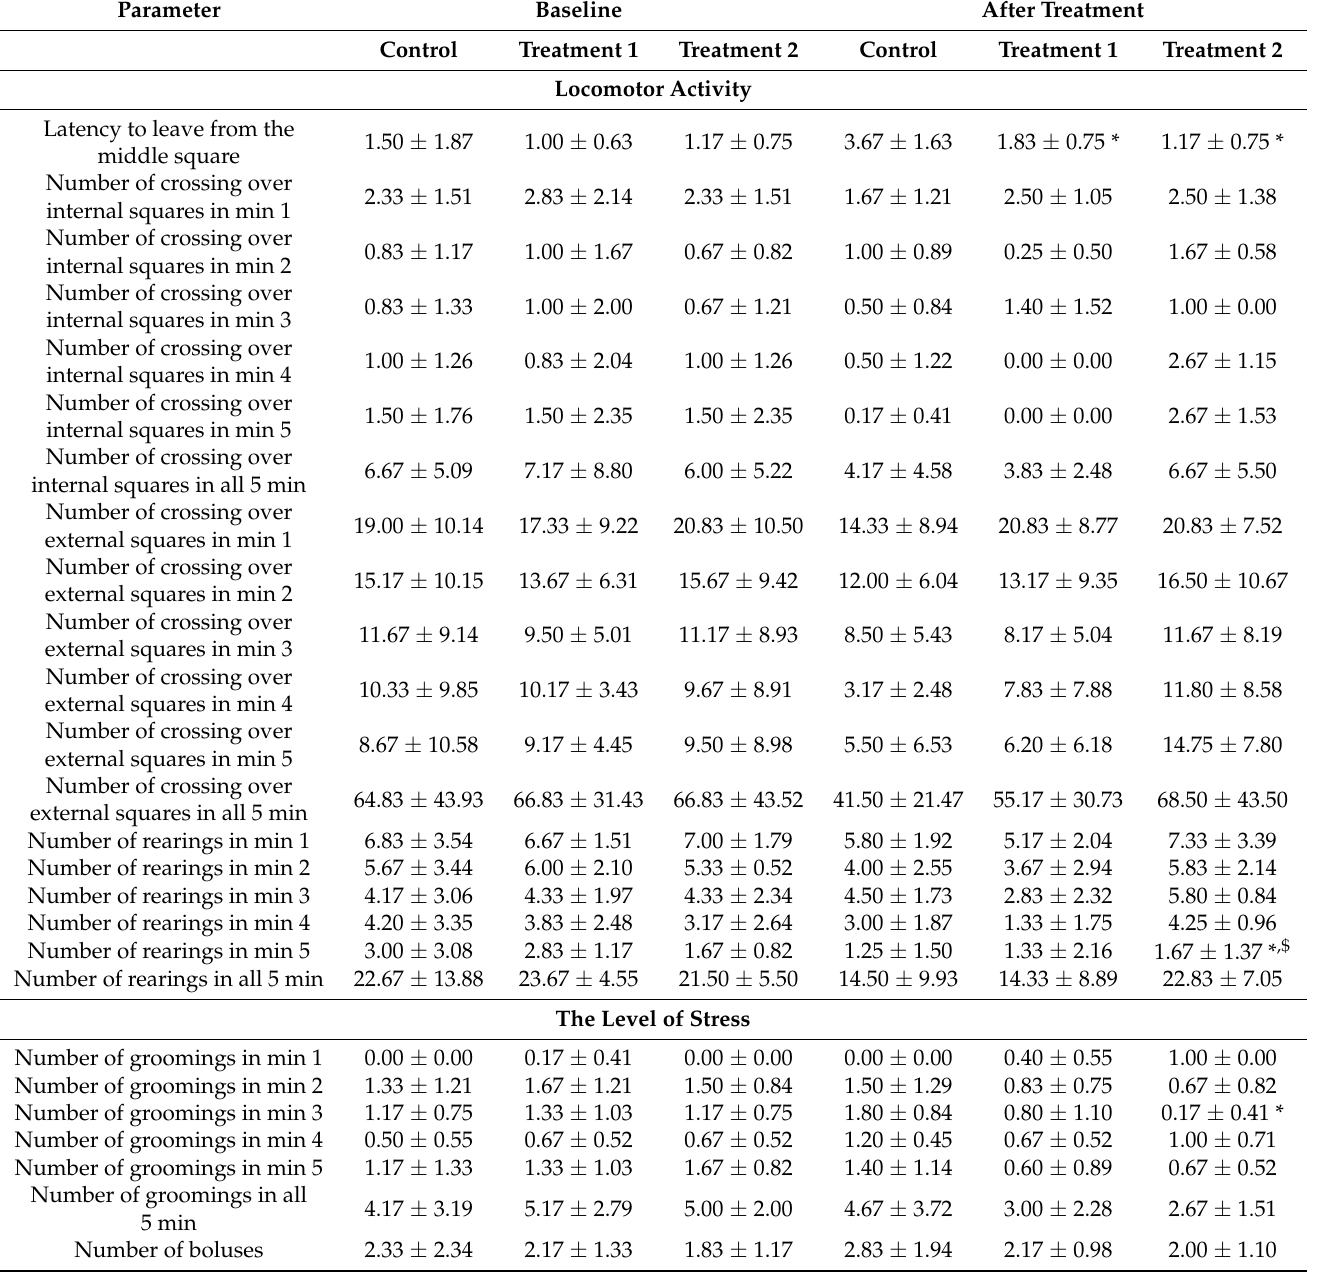
Table 1. Open-field tests result expressed as mean ± standard